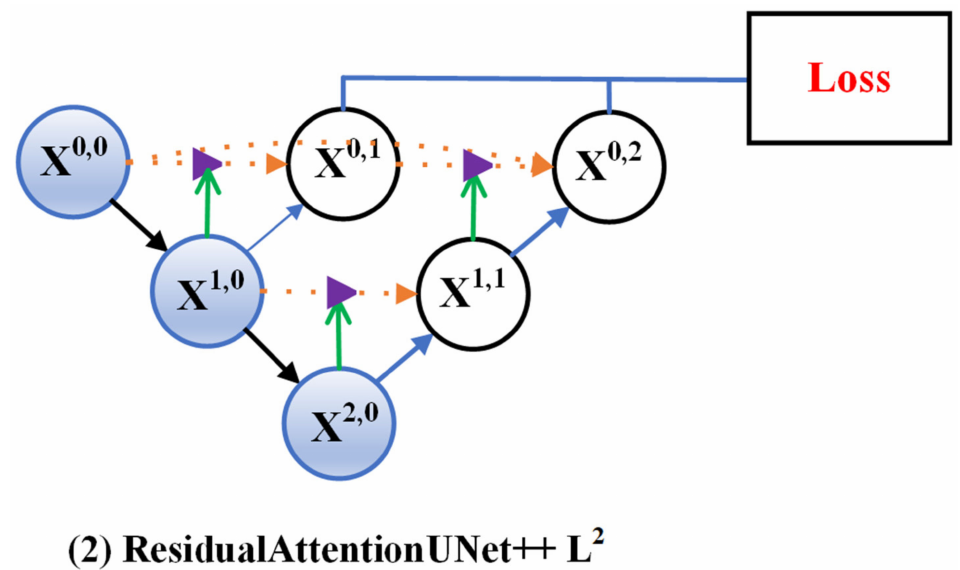
Figure 7. Residual-Attention UNet++ can be pruned to Residual-Attention UNet++ L 2 if trained with deep